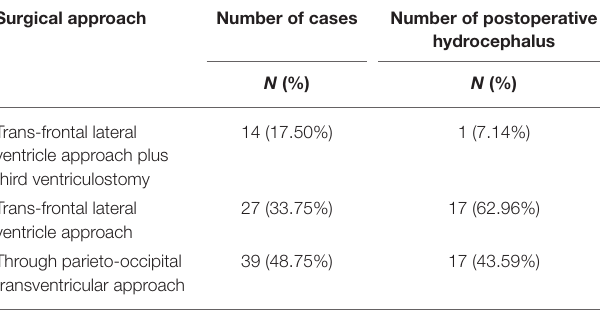
TABLE 3 | Relationship between different surgical approaches and postoperative hydrocephalus of thalamic tumors. Surgical approach